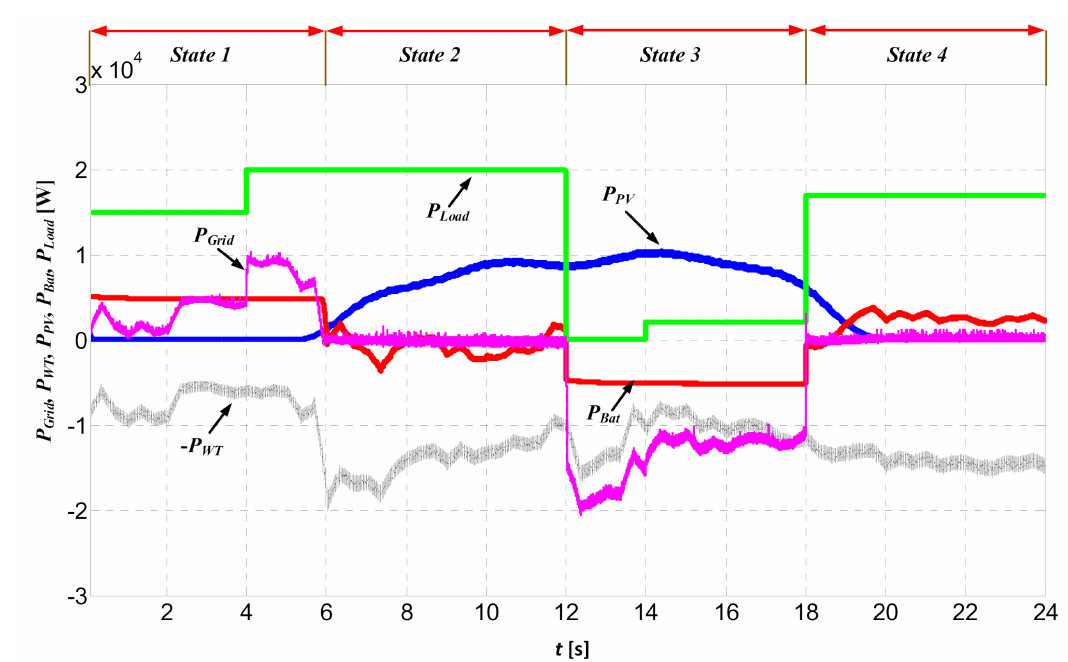
Figure 24. The courses of: Wind turbine and generator output power P WT, photovoltaic power P PV, battery power P Ba t , grid power P Grid , and load power P Load